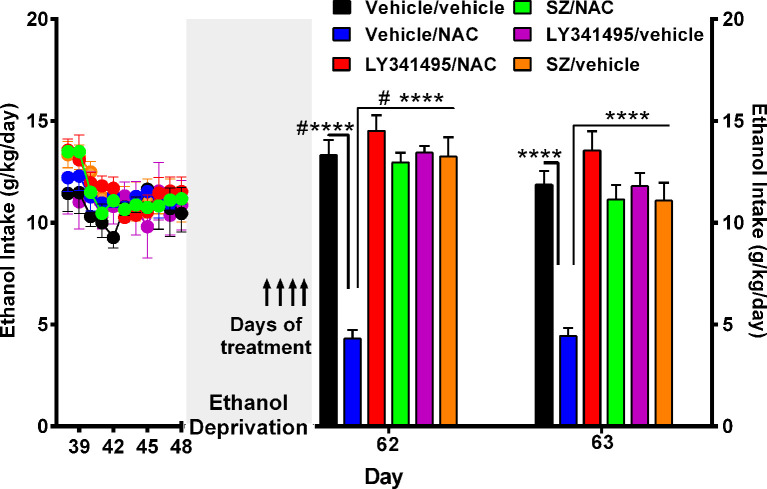
N-acetylcysteine (NAC)–induced inhibition of alcohol relapse-like drinking is prevented by blockade of the glutamate mGlu2/3 receptors (LY3441495) and the xCT-cystine-glutamate exchanger (sulfasalazine, SZ). Following 48 days of chronic ethanol intake and a subsequent ethanol deprivation for 2 weeks, rats received their respective treatment for only the last 4 days of deprivation (arrows in Figure). Given the short administration period, the dose of NAC was increased to 100 mg/kg per day. Ethanol reaccess was allowed 24 h after the last dose of SZ or LY3441495. Following the 2 weeks of alcohol deprivation and ethanol reaccess, the high ethanol intake of the vehicle/vehicle group (black bars) on days 62 and 63 demonstrate the alcohol deprivation relapse. Two-way analysis of variance (treatment × day) performed on ethanol intake data obtained the first (day 62) and second (day 63) days of ethanol reaccess post deprivation revealed significant effect of treatment (Ftreatment(5,46) = 31.0, ****P < 0.0001), day (Fday(1,46) = 21.73, ****P < 0.0001), and significant treatment × day interaction (Finteraction(5, 46) = 20.65, ****P < 0.0001). Tukey post hoc analysis indicated that NAC (vehicle/NAC) induced a significant reduction of alcohol relapse drinking (****P < 0.0001 vehicle/NAC group compared to vehicle/vehicle group), whereas pretreatment with LY341495, an antagonist of the mGlu2/3 receptors, or sulfasalazine (SZ), an inhibitor of the xCT-cystine/glutamate exchanger, fully blocked the NAC-induced reduction of alcohol relapse (****P < 0.0001 LY341495/NAC group vs. vehicle/NAC group; and ****P < 0.0001 SZ/NAC group vs. vehicle/NAC group). However, sulfasalazine at the dose of 8 mg/kg per day administered without NAC (SZ/vehicle group) did not per se inhibit ethanol intake the first or second reaccess day; nor did it show a significant anti-inflammatory effect (vide infra
Figure 6) vs. the vehicle/vehicle group (Tukey post hoc SZ/vehicle vs. vehicle/vehicle group: N.S.). Similarly, LY341495 at a dose of 1 mg/kg per day administered without NAC (LY341495/vehicle group) did not per se inhibit ethanol intake the first or second reaccess day; nor did it show a significant anti-inflammatory effect (vide infra
Figure 6) vs. the vehicle/vehicle group (Tukey post hoc LY341495/vehicle vs. vehicle/vehicle group: N.S.). In addition, sulfsalazine or LY341495 treatments did not influence total fluid intake. Furthermore, 24 h after the administration of sulfasalazine or LY341495, rats were given reaccess to ethanol to recorder their consumption. Data are presented as mean ± SEM, n = 6 rats per experimental group. #P < 0.05 means significant difference with the same group before deprivation. N.S., not statistically significant.